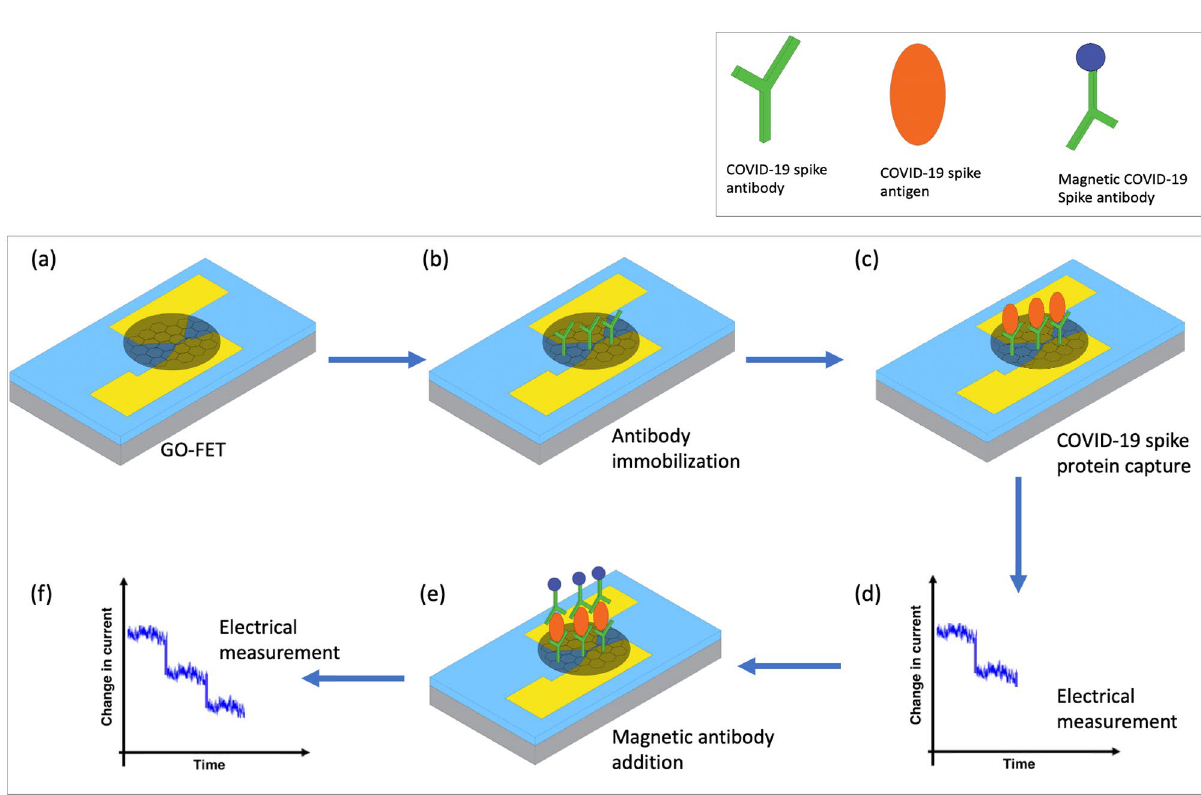
Figure 8. ( a ) Schematic diagram of the GO-FET biosensor. ( b ) COVID-19 spike protein antibody immobilized on the GO-FET channel. ( c ) Target COVID-19 spike protein captured by the biosensor. (d) The electrical current variation due to capturing the spike protein. ( e ) Magnetic COVID-19 spike protein antibody addition. ( f ) The electrical current variation for the GO-FET biosensor due to Magnetic COVID-19 spike protein addition. Sensor